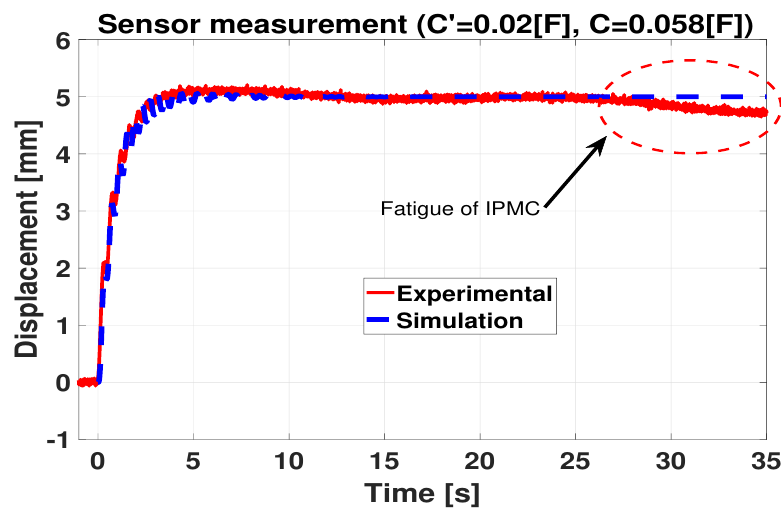
Figure 7. Closed loop response with the fatigue of the IPMC actuator.